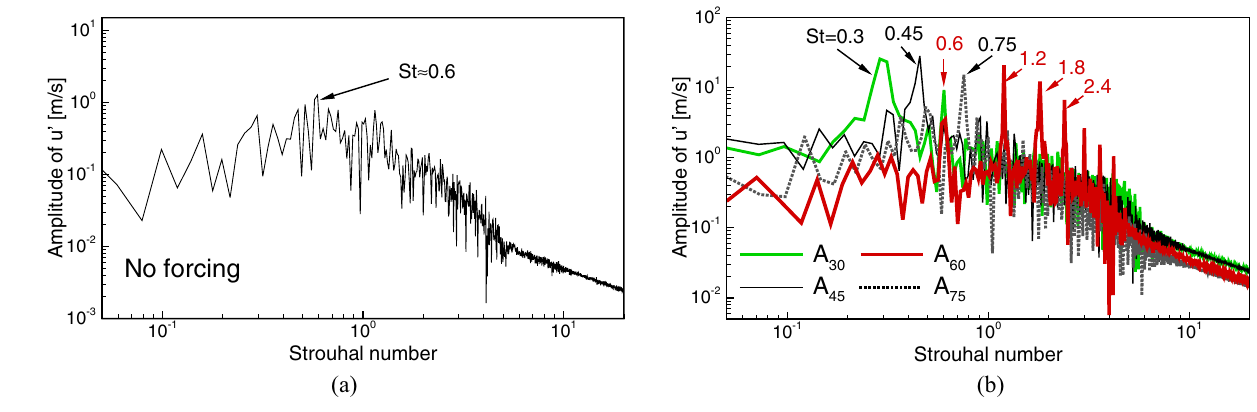
3.0 without forcing ( a ) and with the axial forcing ( b =